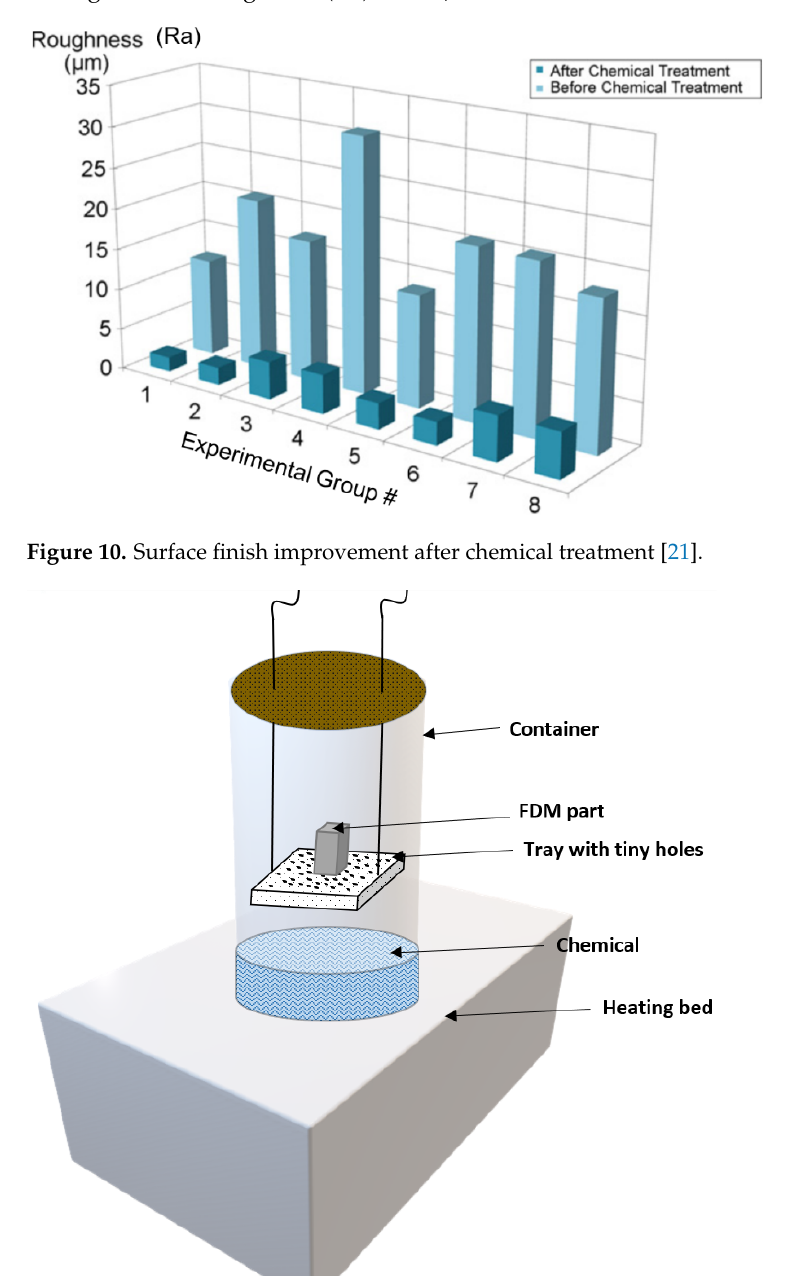
Figure 9. Chemical treatment mechanism: ( a ) before the chemical reaction and ( b ) after the chemical reaction.